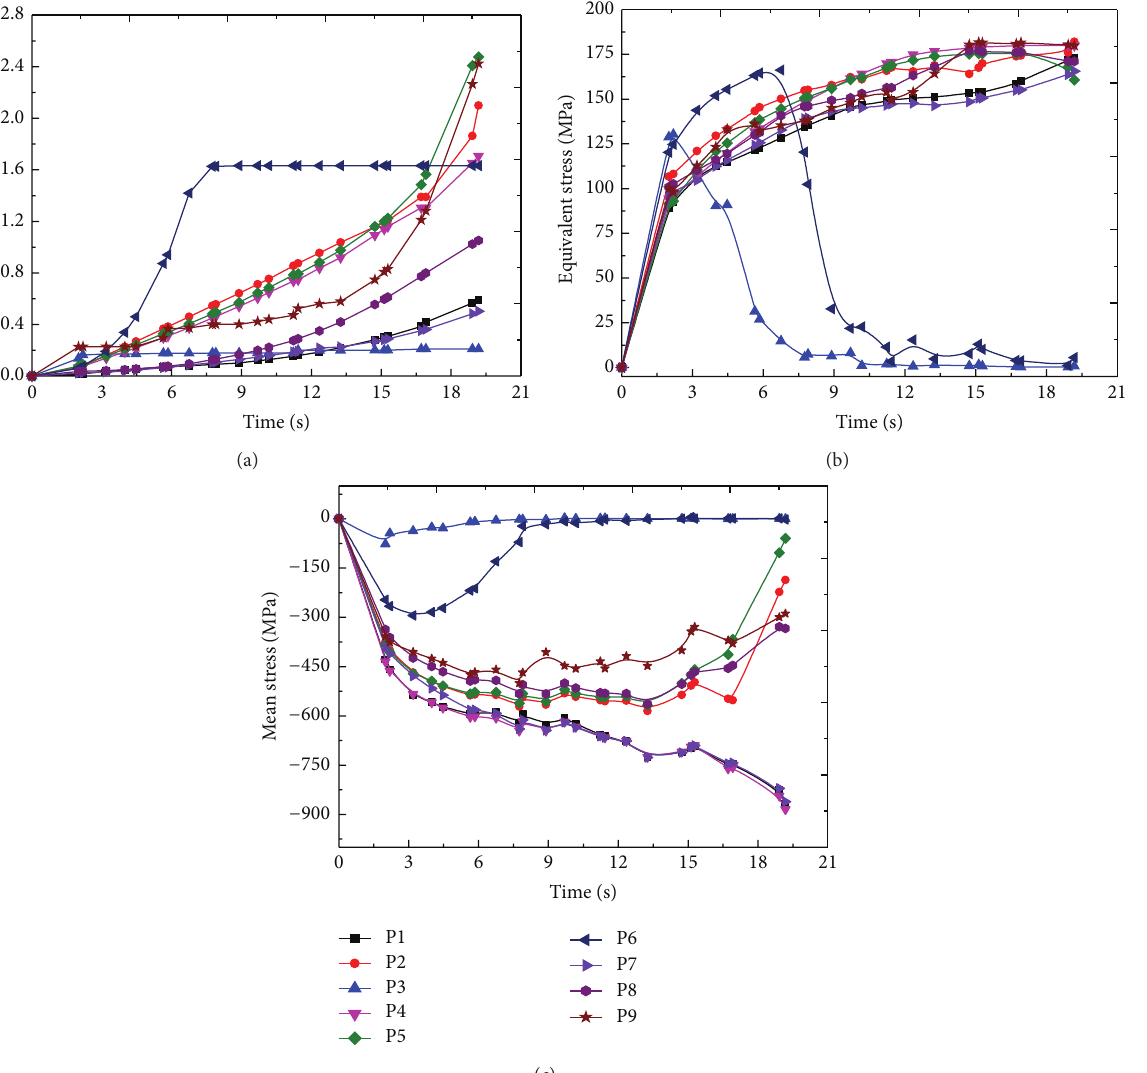
Figure 8: Change of equivalent strain, equivalent stress, and mean stress of typical point with time: (a) equivalent strain; (b) equivalent stress; (c) mean stress.